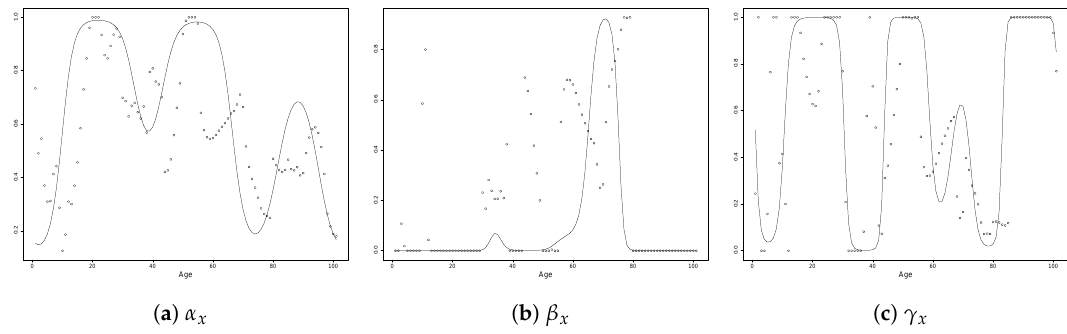
Figure 2. Estimated α x , β x and γ x for Australian male mortality